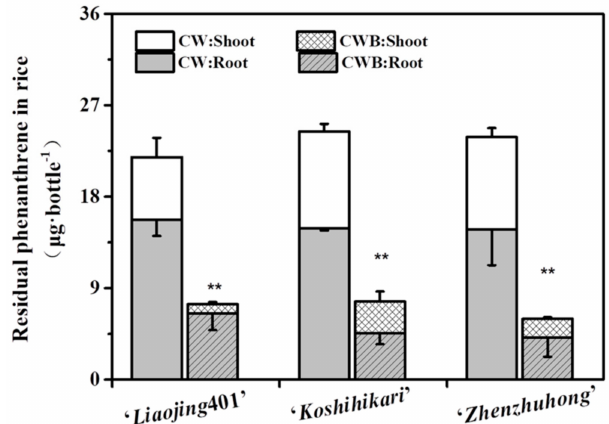
Figure 6. The residual phenanthrene in ‘ Zhengzhuhong ’, ‘ Koshihikari ’ and ‘ Liaojing 401’ root and shoot. plants cultured in phenanthrene-containing Hoagland medium (CW); plants with biofilm cultured in phenanthrene-containing Hoagland medium (CWB). Error bars are shown as ±